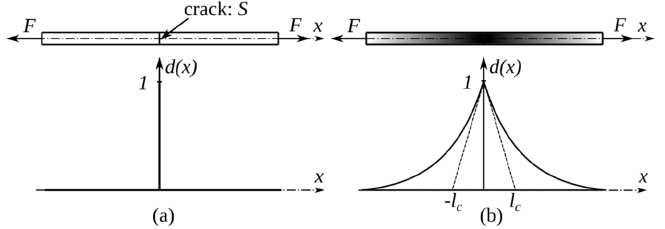
Figure 1 . A bar loaded by forces F on both sides with a crack surface S at the middle: damage phase-field ( a ) for sharp crack and ( b ) for diffusive crack topology [17,20]. By following Miehe et al. [17] formulation for cracks in one-dimensional solids, and the extension of the regularized crack functional to multi-dimensional problems as